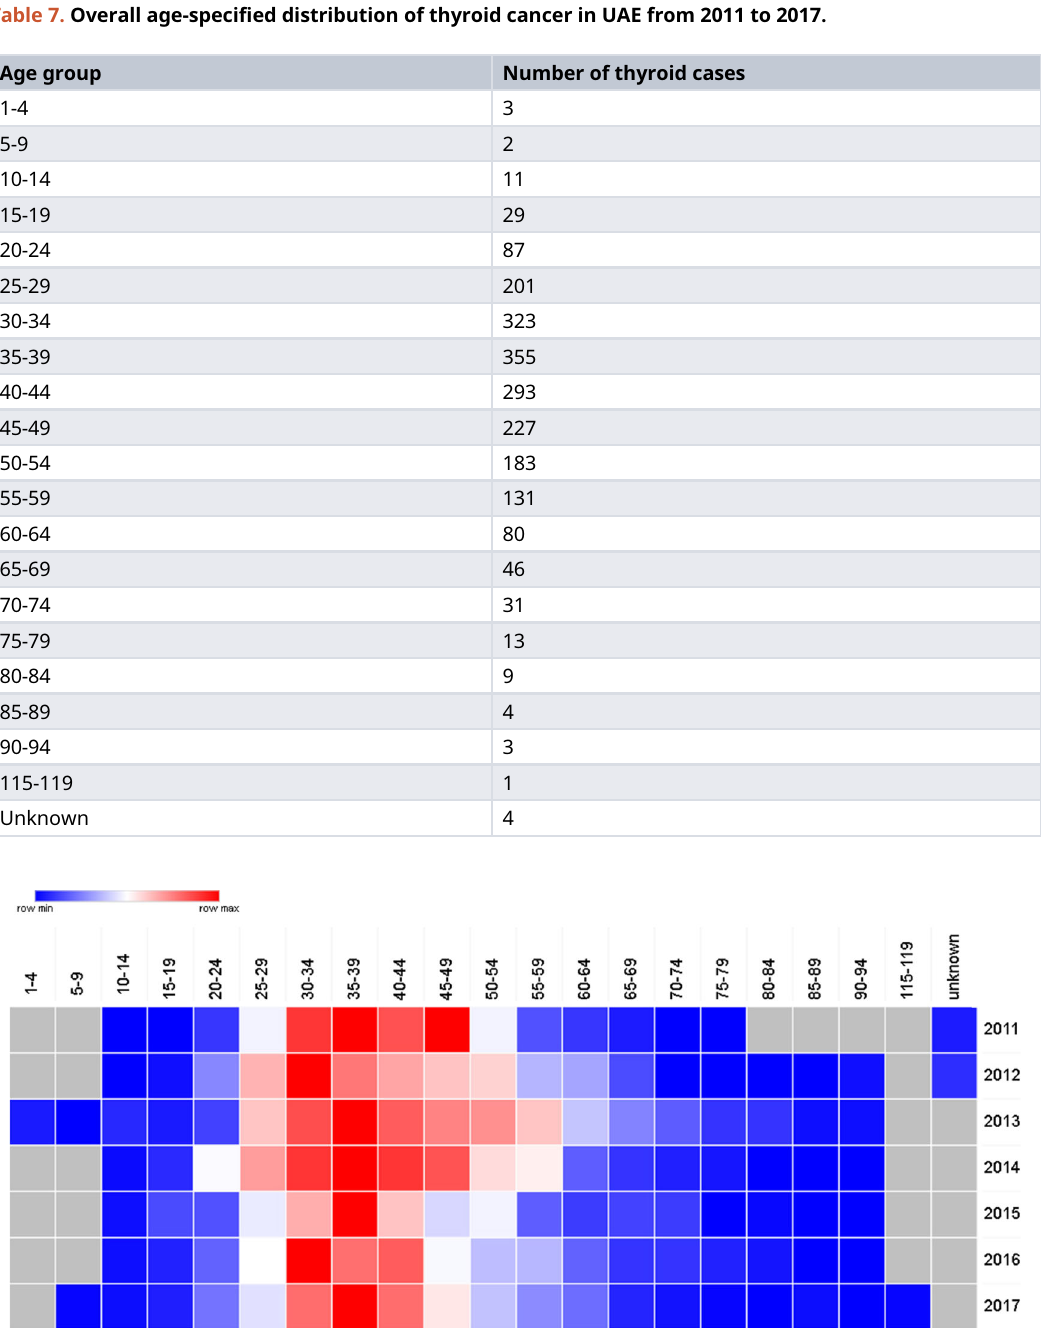
Figure 6A. Heatmap representation for the age distribution of thyroid cancer in UAE from 2011 to